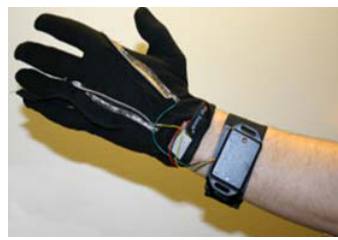
Figure 7. Sensorized glove connected to the measuring unit, which is fastened to the